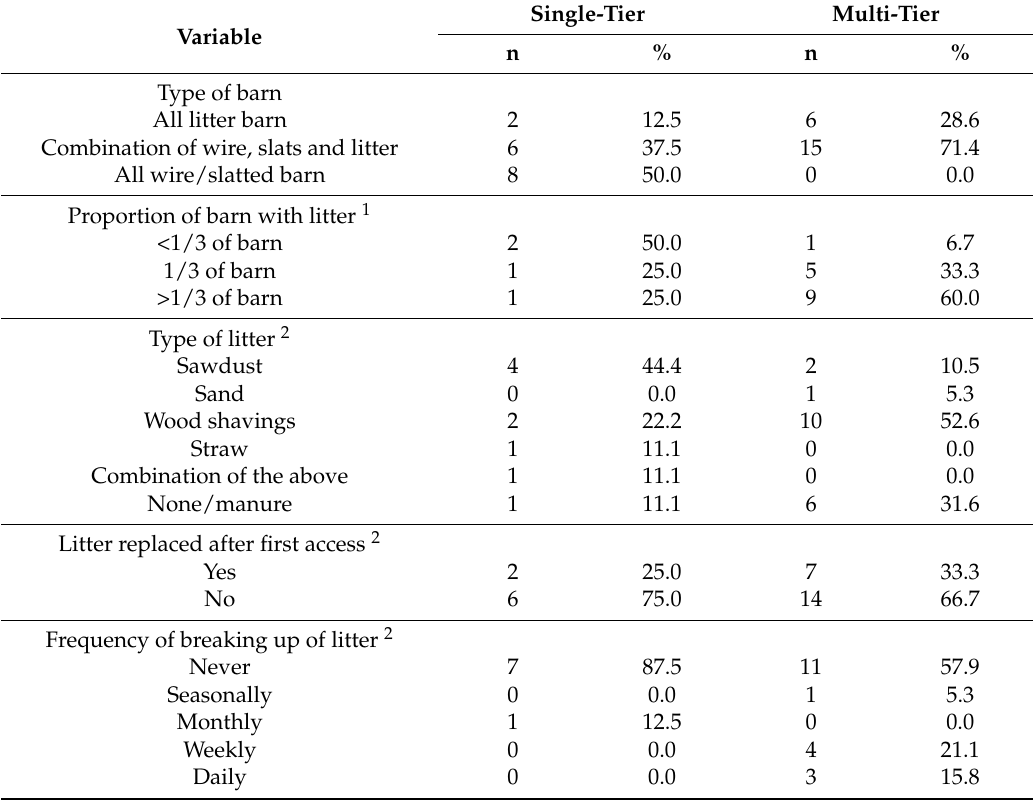
Table 3. Summary of litter management aspects for laying hen flocks placed between October 2016